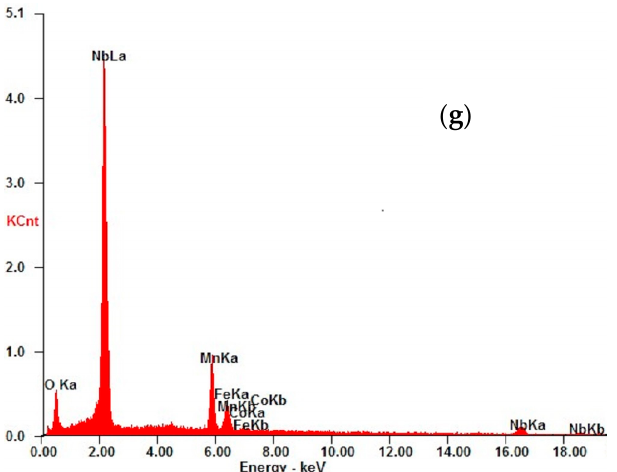
Figure 5. X-ray spectra of niobium minerals by EDS. ( a ): Nioboaeschynite-(Nd); ( b ): ilmenorutile; ( c ): fergusonite; ( d ): baotite; ( e ): euxenite-Y; ( f ): latrappite; ( g ): columbite-(Mn). Table 4. Mass fraction of niobium in mineral phase (%).